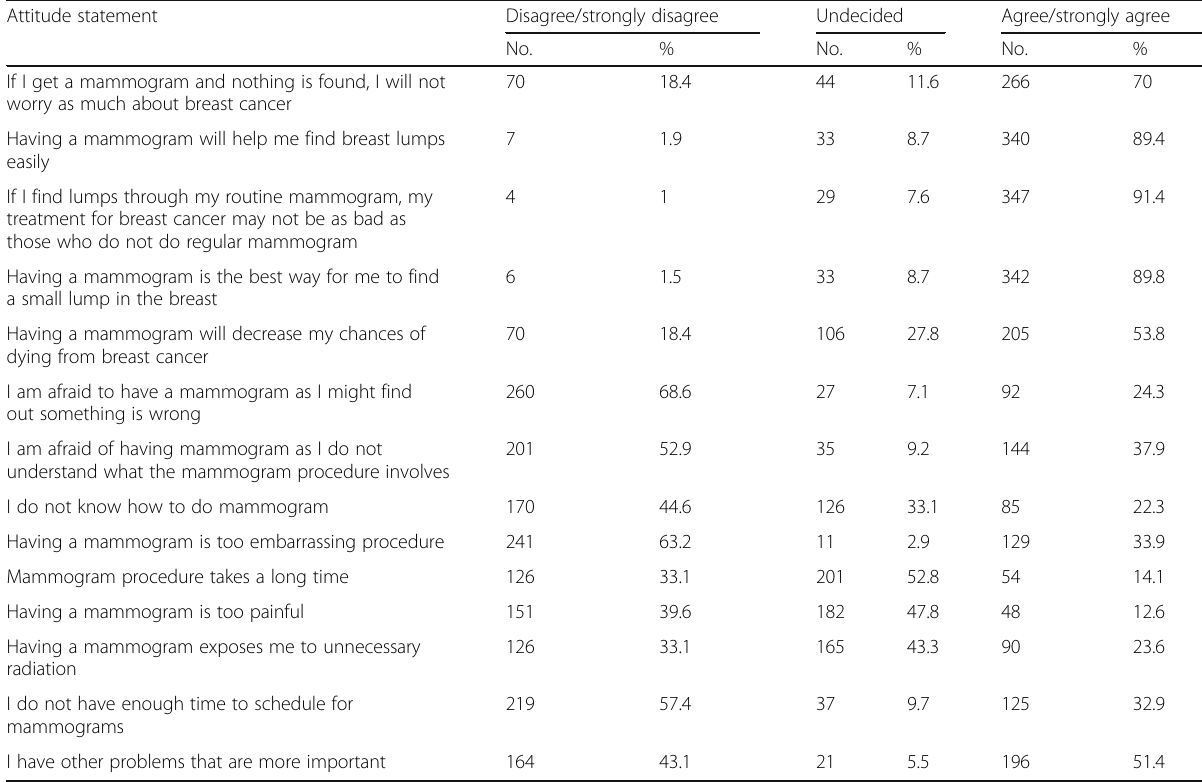
Table 3 Attitude of participating women towards breast cancer screening Attitude